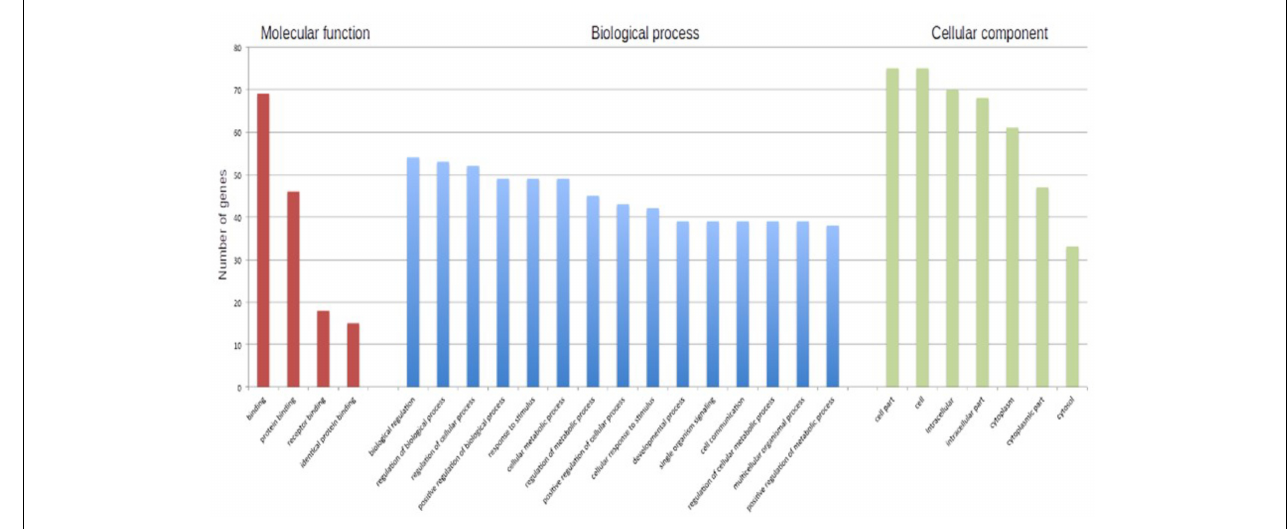
FIGURE 7 | The barplot shows the number of ALS-associated genes enriched in each of reported GO term.